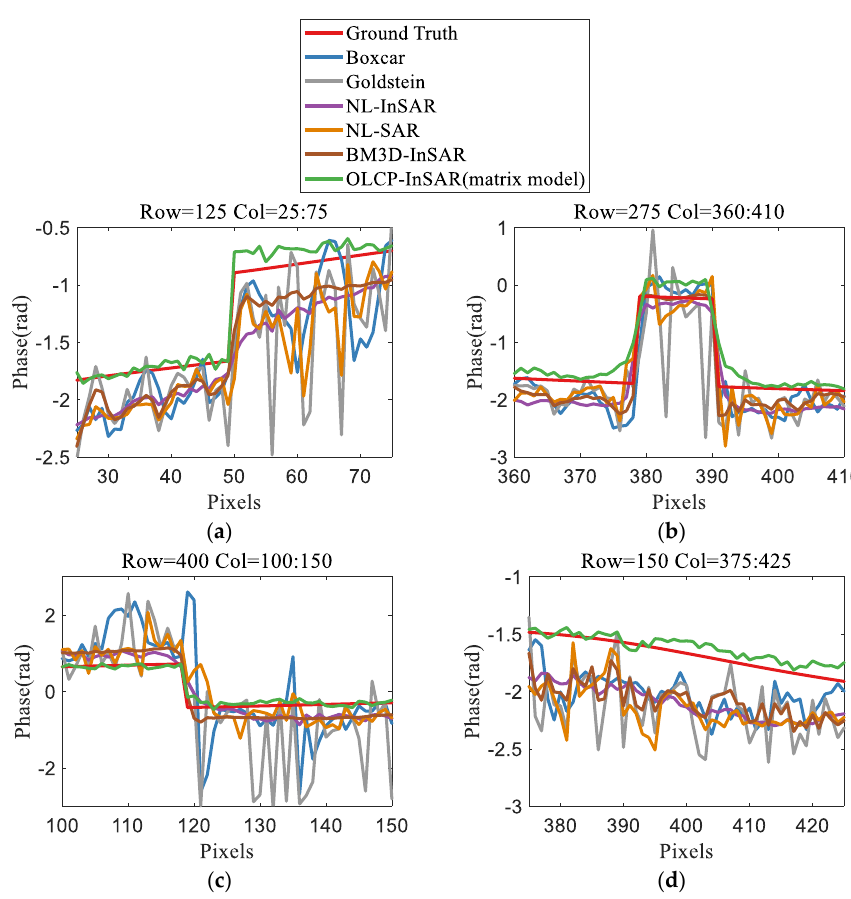
Figure 13. The filtered phase profiles with OLCP-InSAR (blue line) and other reference filtered methods based on tensor decomposition. ( a ) The filtered phase profiles at row 125 and column 25 to 75. ( b ) The filtered phase profiles at row 275 and column 360 to 410. ( c ) The filtered phase profiles at row 400 and column 100 to 150. ( d ) The filtered phase profiles at row 150 and column 375 to 425.